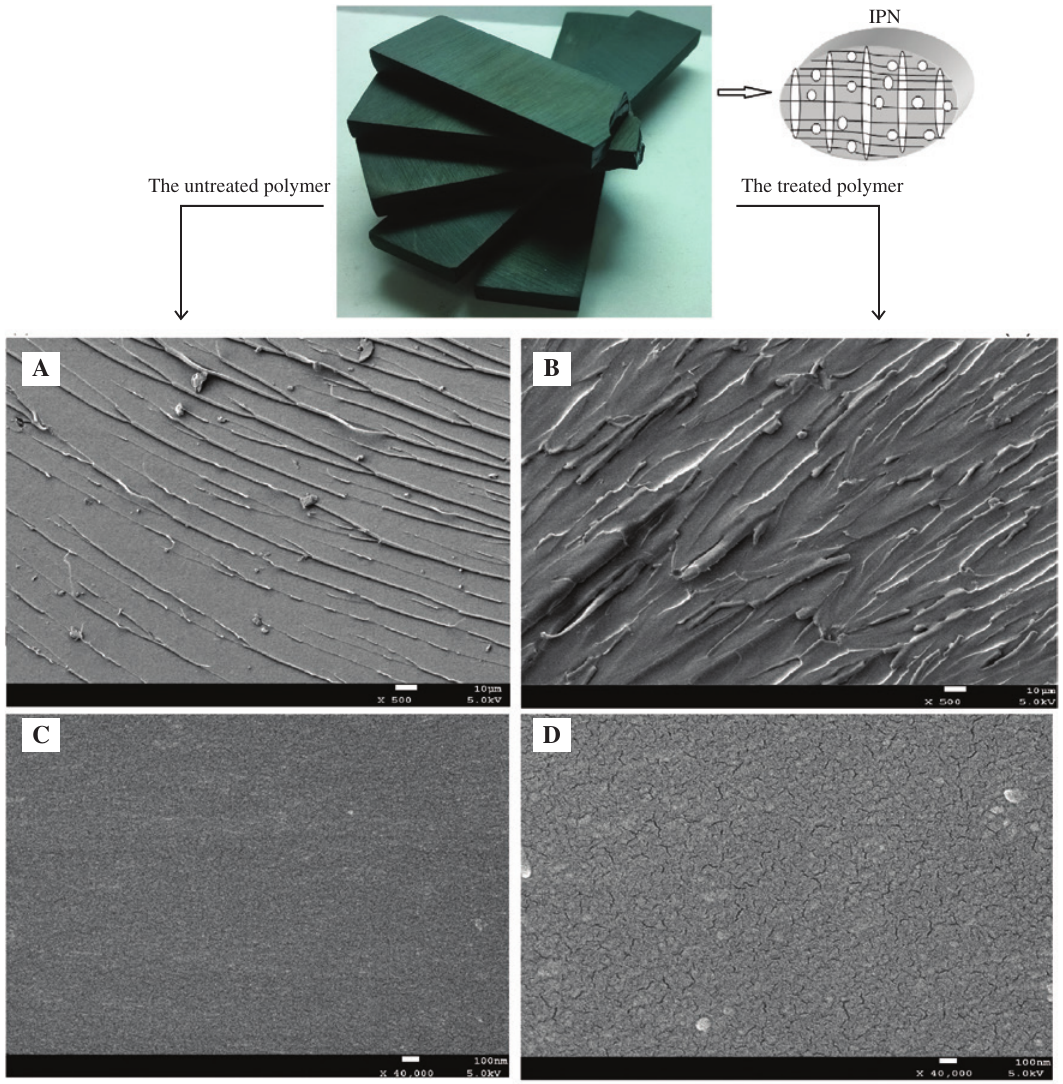
Figure 11: SEM micrographs of untreated BAPh/PEN-OH polymers at lower (A) and higher (C) magnification as well as BAPh/PEN-OH polymer treated with NMP at lower (B) and higher (D)